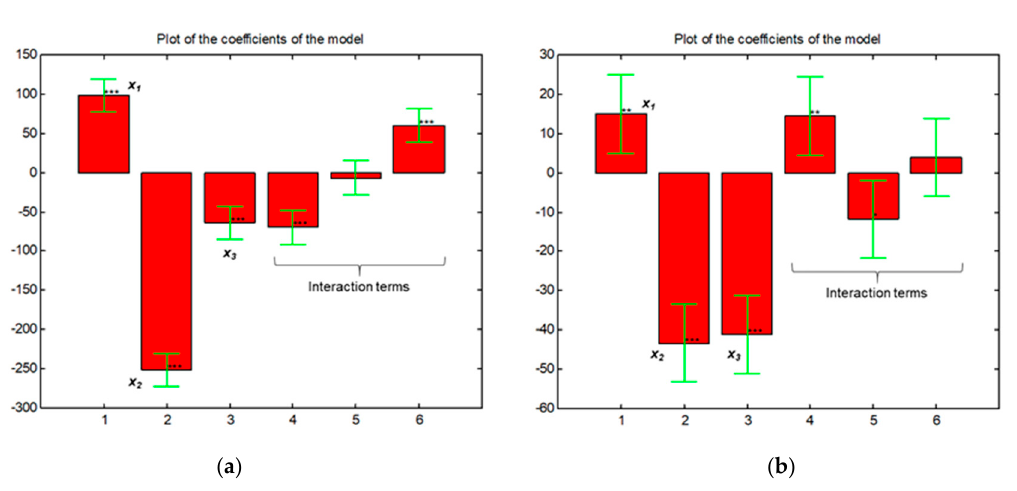
Figure 1. Plots of the coe ffi cients of the model for ( a ) DMASnBr 3 / g-C 3 N 4 and ( b ) PEA 2 SnBr 4 / g-C 3 N 4 . Stars indicate the significance of the coe ffi cients (* p < 0.05, ** p < 0.01, *** p < 0.001), while error bars indicate the confidence intervals ( p = 0.05).